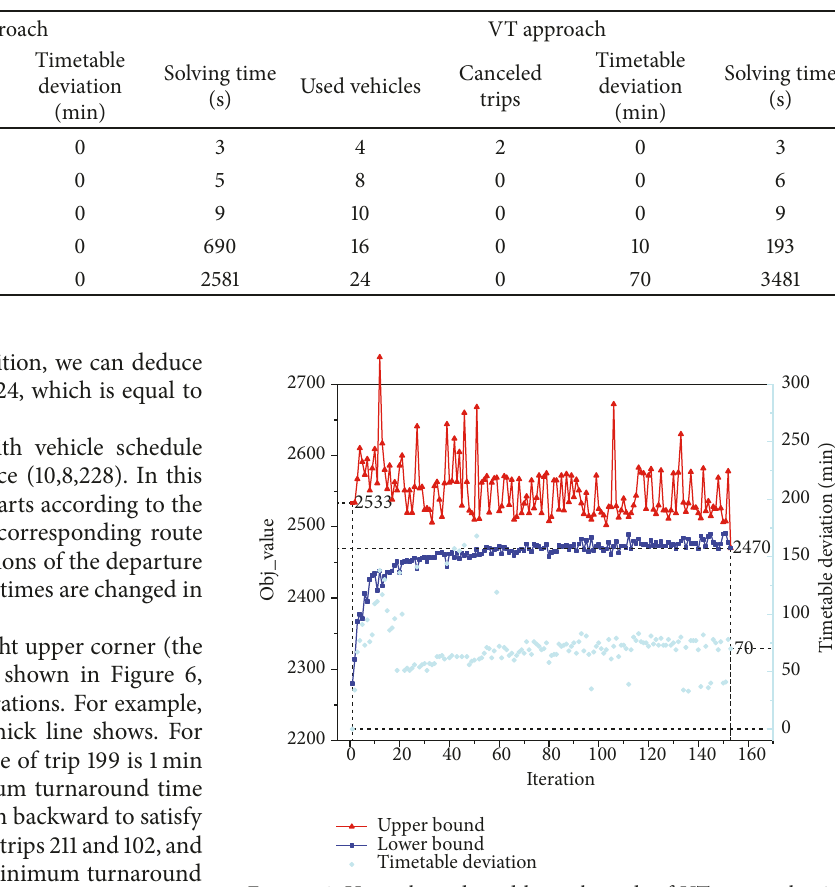
Figure 4: Upper bounds and lower bounds of VT approach with timetable deviations at Benders-and-Price